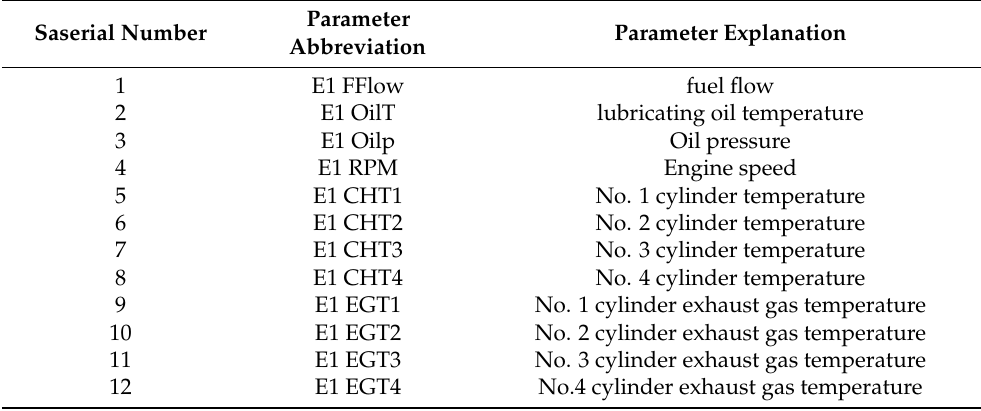
Table 1. Flight data engine data